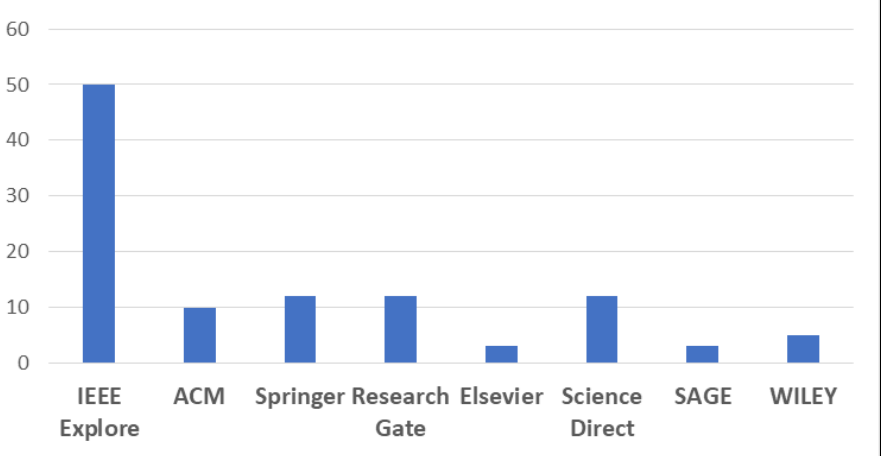
Figure 5. Repositories versus number of studies